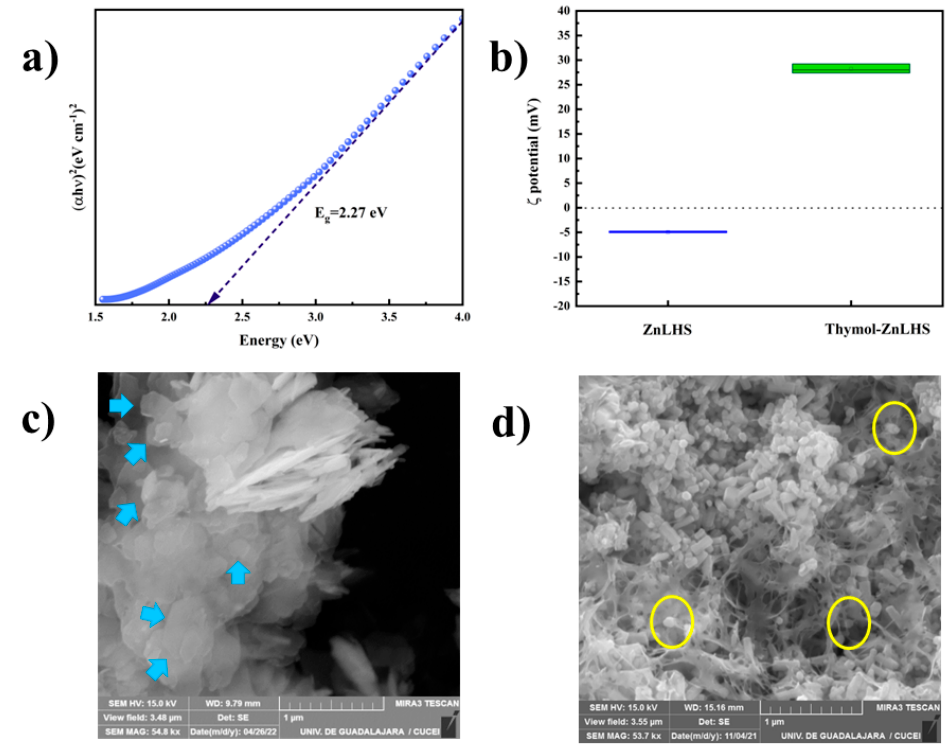
Figure 7. Optical energy plot and zeta potential. ( a ) Bandgap of Simonkolleite (ZnLHS) and ( b ) ζ− potential of Simonkolleite (ZnLHS) and thymol–ZnLHS, respectively. Scanning electronic microscopy: ( c ) ZnLHS and ( d ) thymol–ZnLHS.